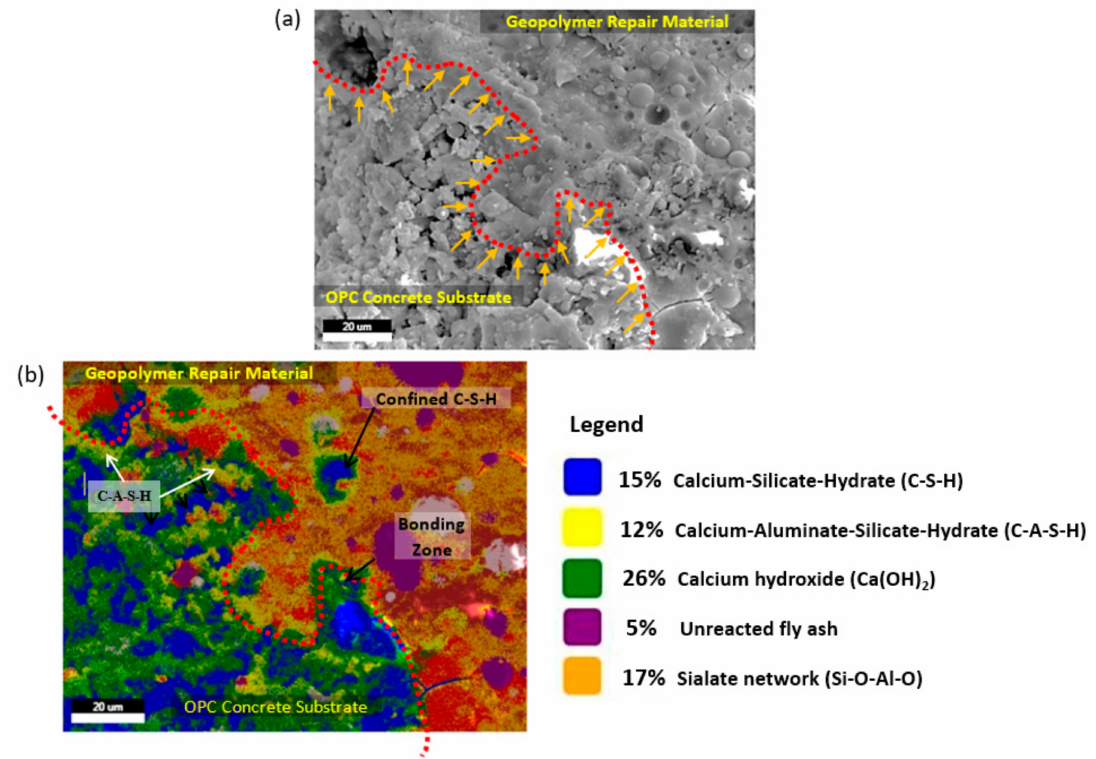
Figure 11. Bonding zone between the GRM and the OPCC substrate: ( a ) microstructure; ( b ) compound element mapping at the bonding